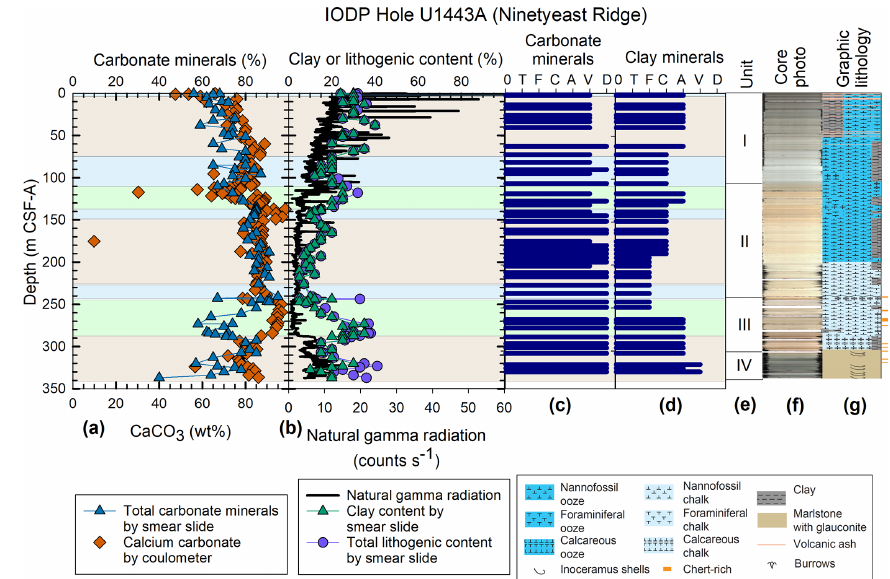
Figure 4. Downcore data from Site U1443. (a) Comparison of carbonate mineral percentages estimated from smear slides (blue triangles for major lithology to CaCO 3 measured by carbonate coulometer – orange diamonds). (b) Comparison of the clay fraction (green triangles) and total lithogenic fraction (purple circles) estimated from smear slides to natural gamma radiation measured by whole round core scanning (black line). The colored zones indicate the smear slide estimates from three observers. Panels (c) and (d) are the abundance categories of total carbonate minerals and total clay minerals, where 0 is none, T is trace ( < 1%), F is few (1% to 9%), C is common (10% to 24%), A is abundant (25% to 40%), V is very abundant (41% to 74%), and D is dominant ( > 75%) as presented in the IODP 353 Proceedings. (e) Lithostratigraphic units from visual core description. I: clayey nannofossil ooze with foraminifers, II: nannofossil ooze/chalk with clay and foraminifers, III: clayey calcareous/nannofossil chalk with foraminifers and authigenic carbonate, and IV: marlstone with glauconite (Clemens et al., 2016b). (f) Core photo composite. (g) Lithologic column.